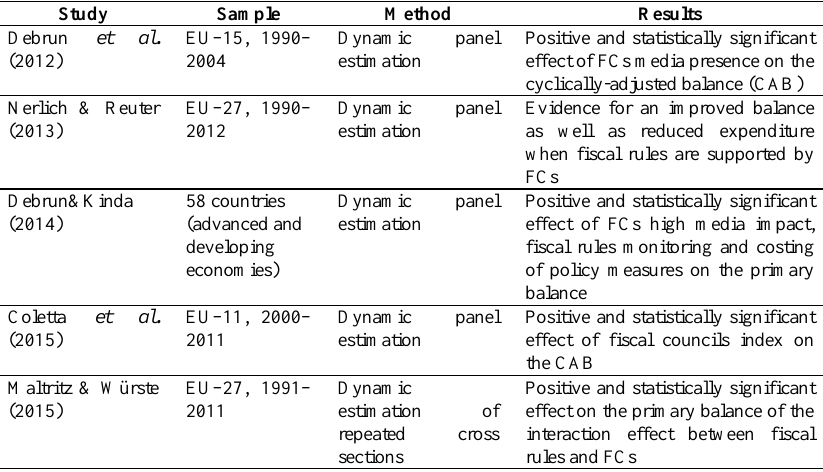
Table 2. Summary of the recent empirical studies on the effectiveness of